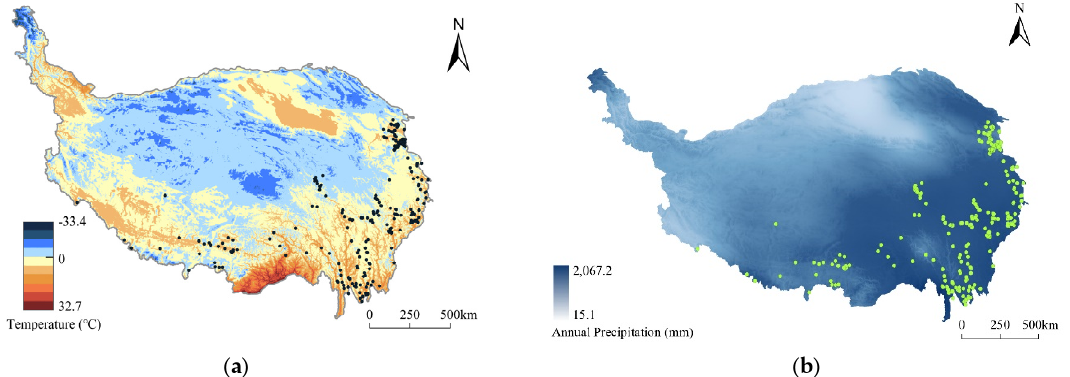
Figure 10. Distribution of traditional villages coupled with different conditions on the Tibetan Plateau: ( a ) the spatial overlay analysis of village distribution and annual temperature; ( b ) the spatial overlay analysis of village distribution and annual precipitation.